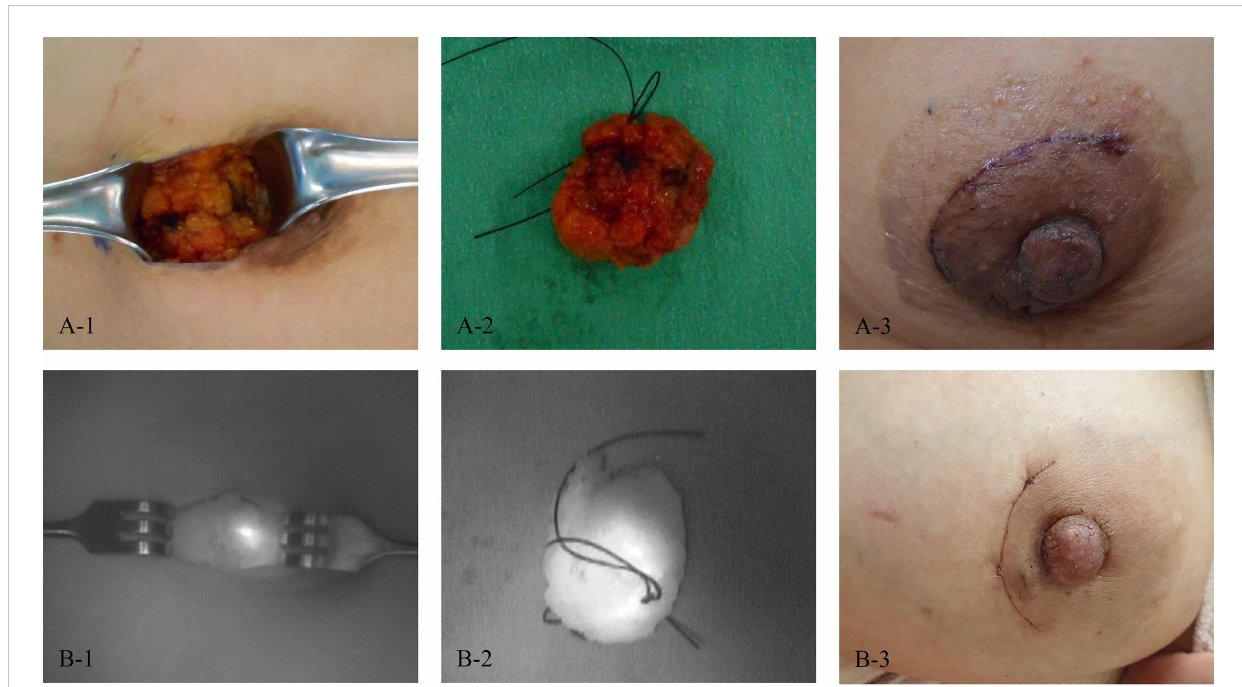
FIGURE 3 Photos of patients. (A) A patient in the control group (1, After skin incision; 2, After excision; and 3, On the last follow-up day). (B) A patient in the study group (1, After skin incision; 2, After excision; and 3, On the last follow-up